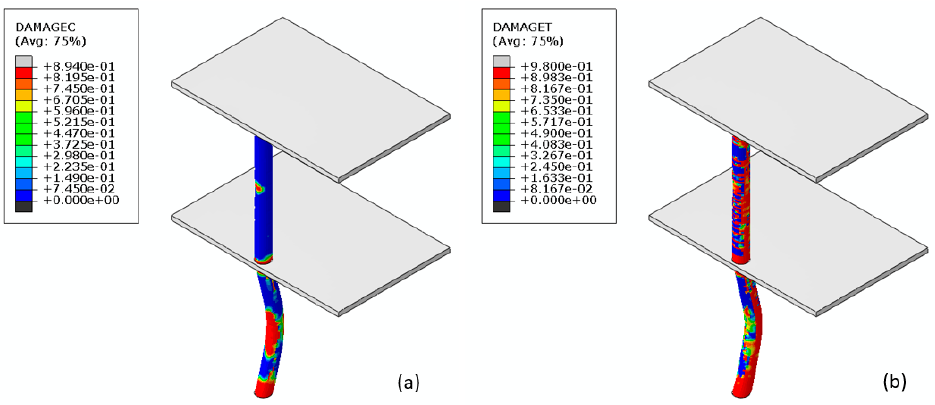
Figure 26. ( a ) Compressive and ( b ) tensile damage in the columns for the RC system.